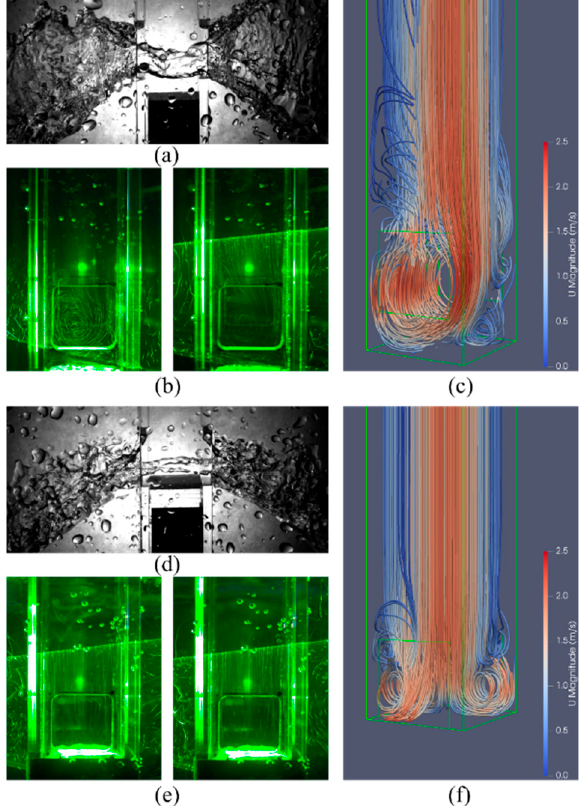
Figure 3. Hydrodynamic behavior inside the nozzle: ( a , b ) Physical simulations of type A NIP; ( c ) Numerical simulations of type A NIP; ( d , e ) Physical simulations of type B NIP; and ( f ) Numerical simulations of type B NIP.